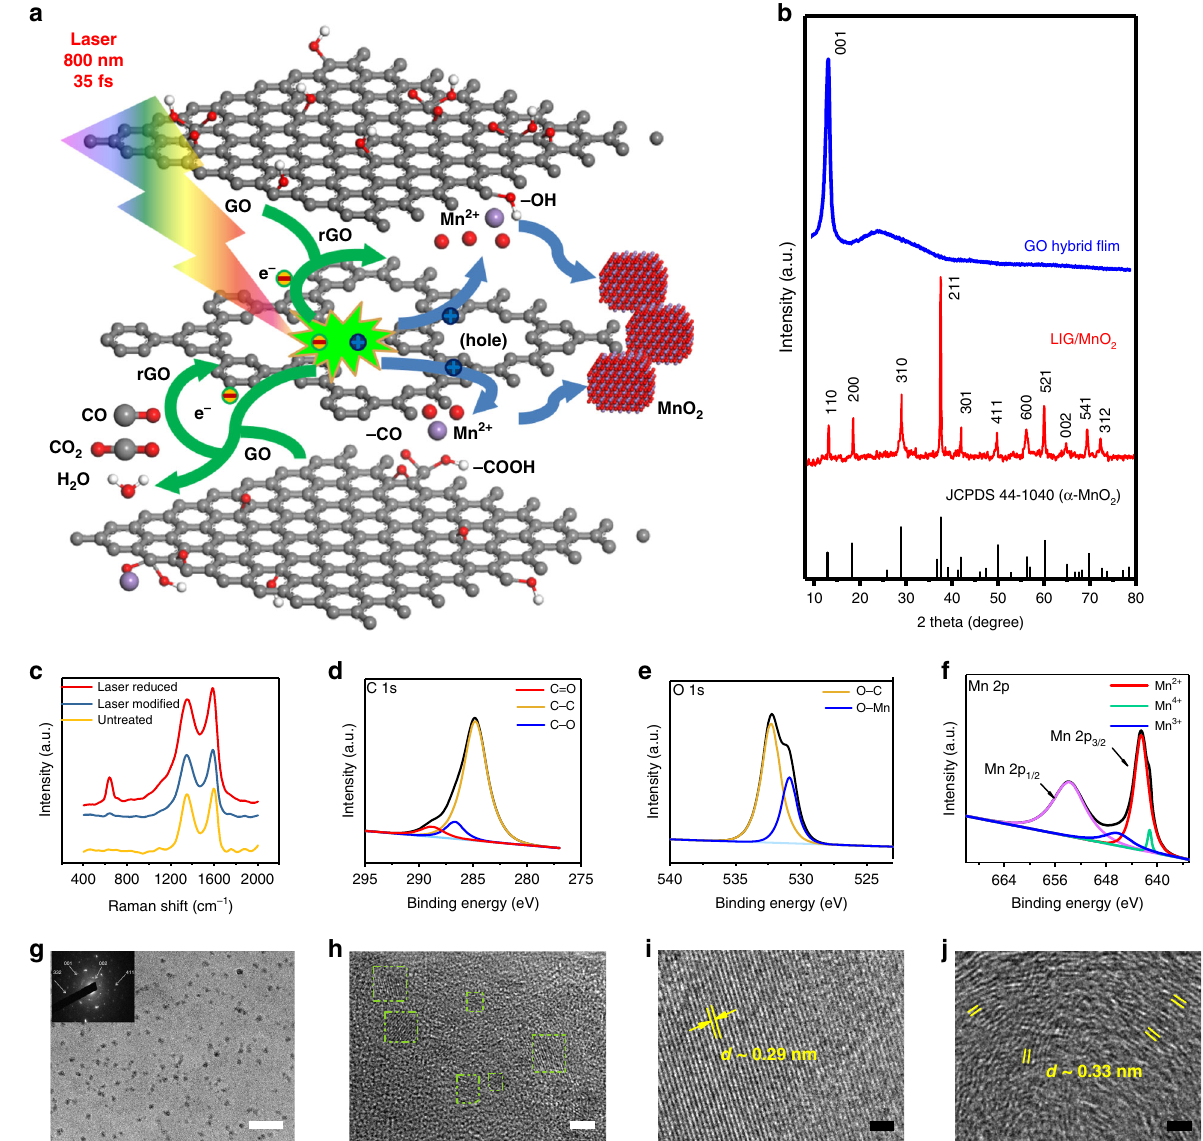
Fig. 3 The mechanism and analytical characterization of LIG/MnO 2 by SSFL. a The schematic of the resultant morphology change and phase transformation by SSFL under the proposed photochemical routes. b XRD patterns of GO and LIG/MnO 2 . c Raman spectra of GO hybrid fi lm untreated, modi fi ed and reduced by SSFL. d − f C 1s, O 1s and Mn 2p XPS core level spectra of LIG/MnO 2 fi lm. g Large area of uniform MnO 2 nanoparticles scattered on LIG (scale bar, 100 nm). h High-resolution TEM (HRTEM) image of MnO 2 nanoparticles scattered on LIG (scale bar, 2 nm). i , j HRTEM image of selected area indicated lattice space (scale bar, 2